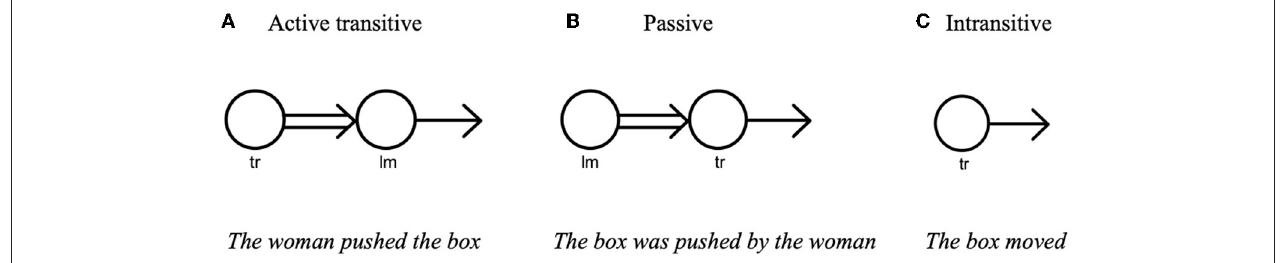
FIGURE 1 | Profiling of different constructions (Langacker, 2008, p. 385)—From the left, it should be labeled (A–C) . Bold lines indicate the aspect of the event being profiled; the double arrows represent the exertion of force; the single arrows represent a change of state; “tr” and “lm” stand for “trajector” and “landmark,”